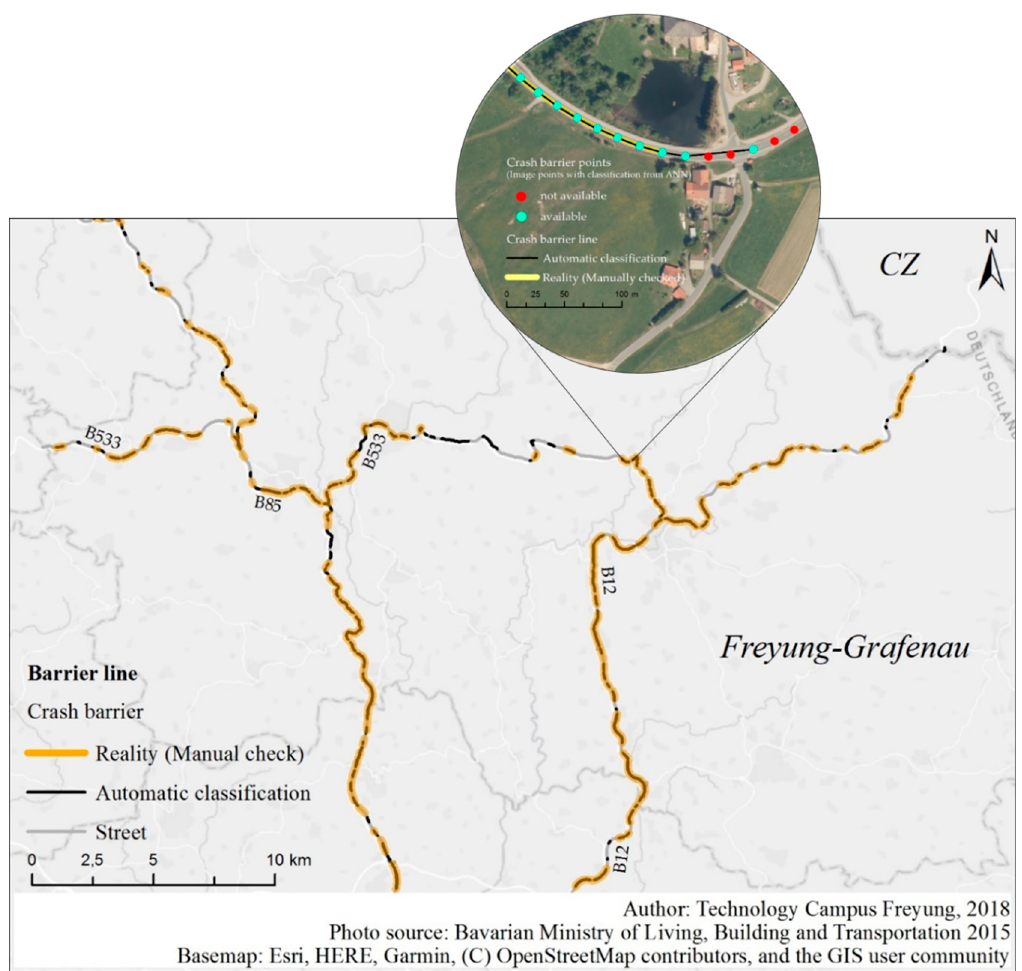
Figure 6. Map of classified crash barriers (black line) in comparison to reality (manual check, orange line).